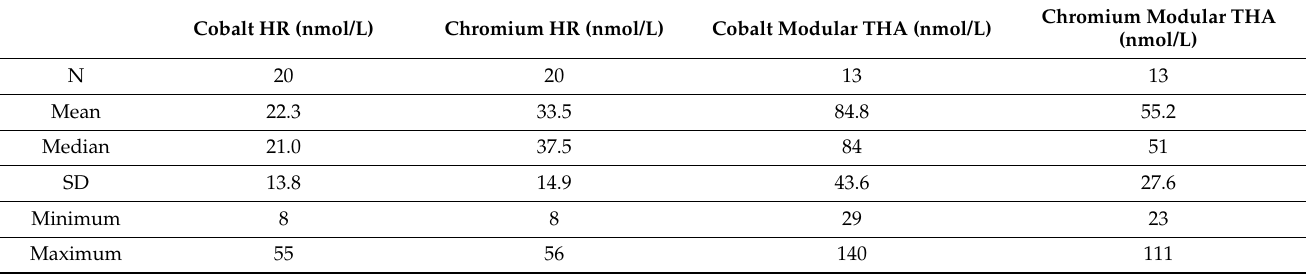
Table 4. Ion Levels